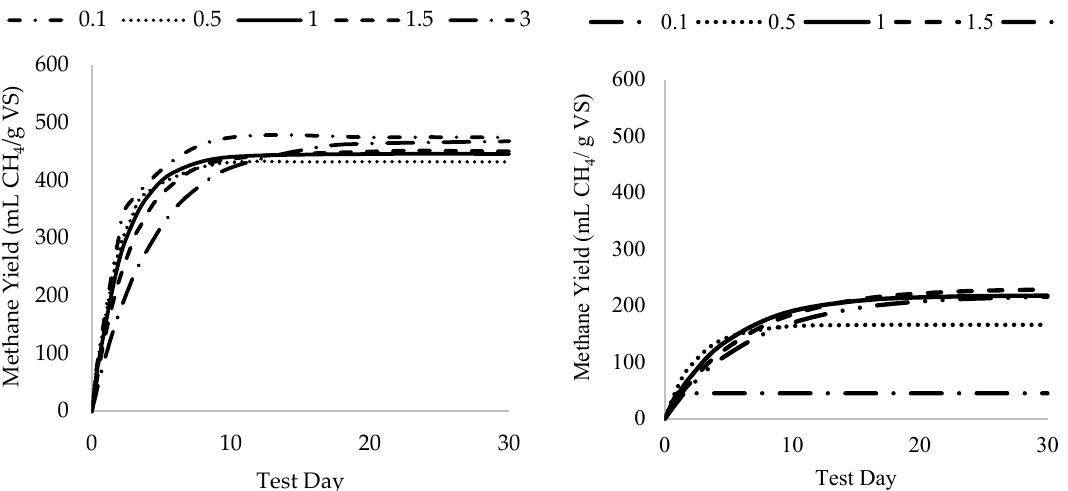
Figure 6. Left : Primary sludge ratio test kinetic modelling of methane yield, right : secondary sludge ratio tests kinetic modelling.